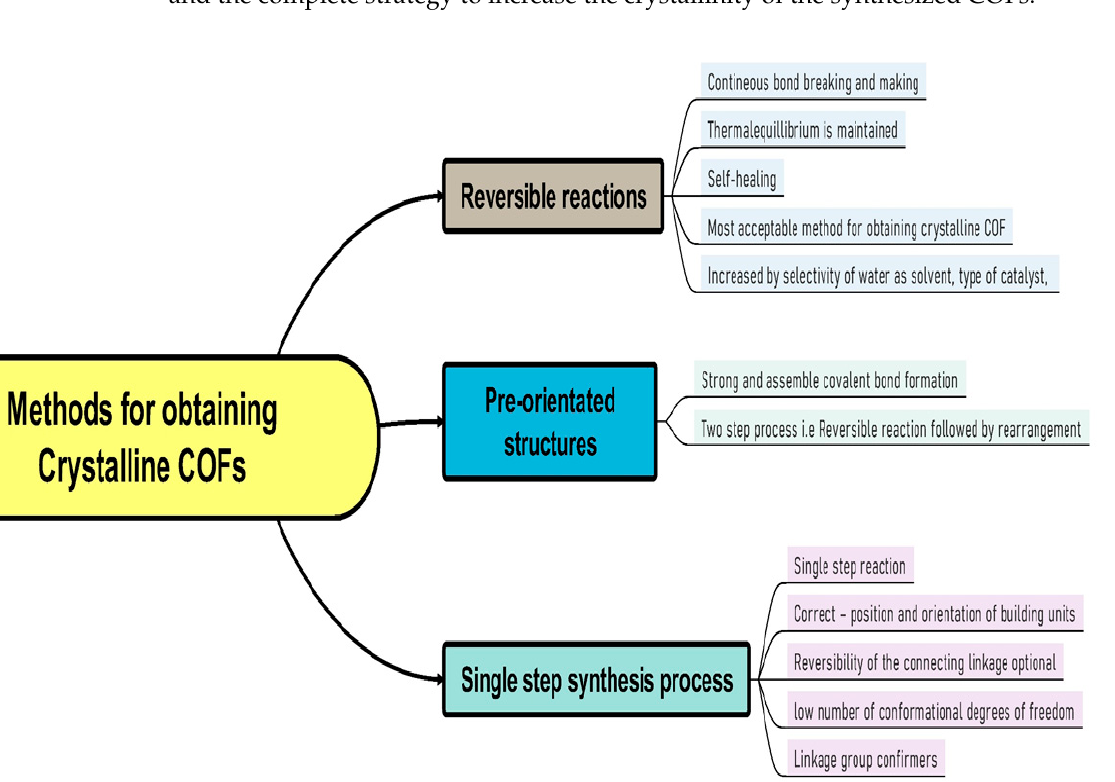
Figure 6. Complete schematic representation to obtain highly crystalline COFs [5]. 2.2. Design Principle and Topology of COFs The designing principle behind the COF is a condensation reaction. Polymerization processes are centered on the self-condensation of a substituted monomer or the co-con- densation of monomer units with two distinct functional groups. In the self-condensation process, single monomers with active functional groups are combined, whereas in the co-